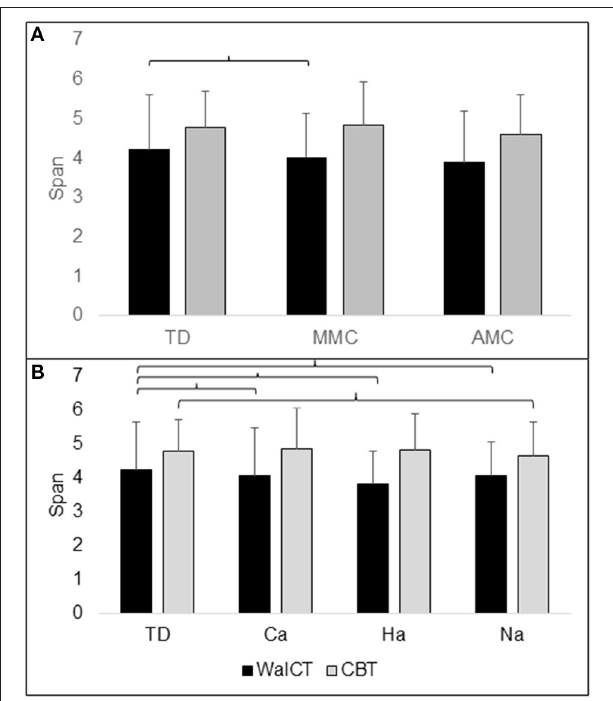
FIGURE 3 | Illustration of Raven total score (CPM) in (A) groups of MMC (myelomeningocele) and AMC (artrogryphosis multiplex congenita) and (B) in groups of Ca (community ambulation), Ha (household ambulation) and Na (non-ambulation). Parentheses indicate significant